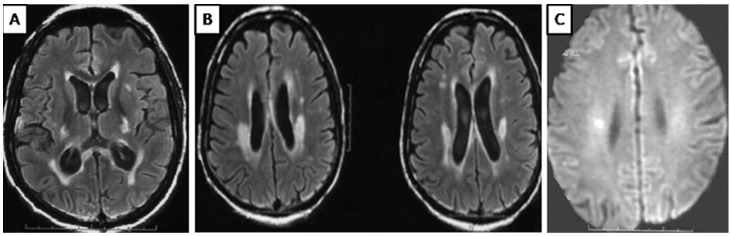
Cranial T2 FLAIR MRI axial sections in a 45- year-old male, stage III tuberculous meningitis (TBM) with type 2 diabetes mellitus and hypertension, and a 15-year-old male, stage III TBM patient.(
A and
B) Infarcts are shown in the (
A) ischemic and (
B) peri ventricular region bilaterally (internal border zone) of the 45- year-old male. Cerebral salt wasting (CSW) was diagnosed on Day 40. The patient developed infarctions on Day 68 of admission. Hyponatremia was corrected after 12 days and urinary output normalized after 3 months. (
C) 15-year-old male showing asymptomatic infarct in right peri-ventricular white matter (internal border zone) with CSW diagnosed at admission (Day 1). (Reproduced from Misra UK, Kalita J, Kumar M,
et al.: Hypovolemia due to cerebral salt wasting may contribute to stroke in tuberculous meningitis.
QJM. 2018; 111(7): 455–60; with permission)
38.